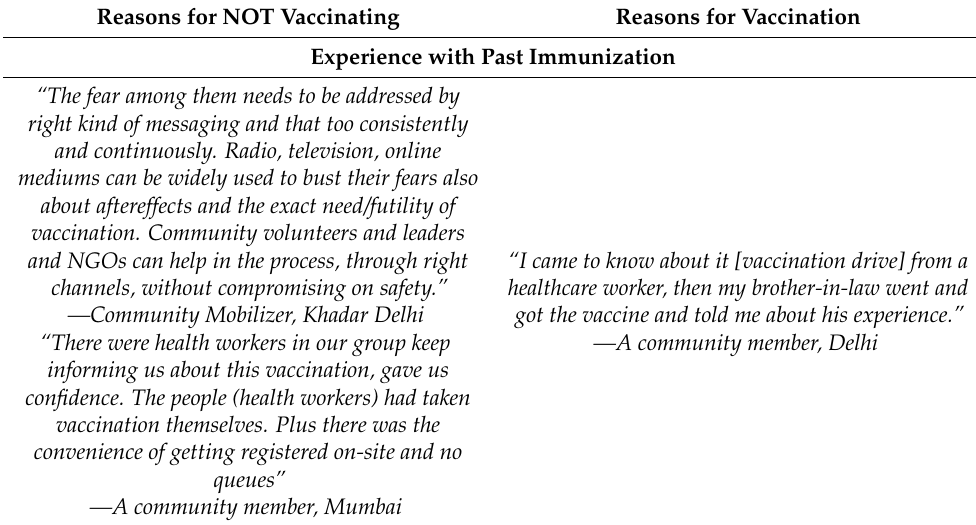
Table 15. Description of theme experience with past immunization with